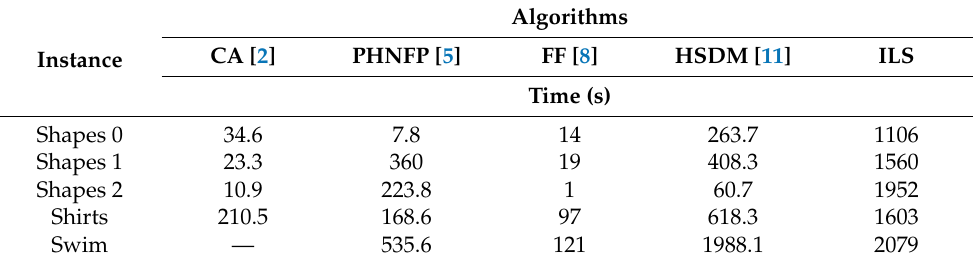
Table 7. Time used to find the same solution using different algorithms.